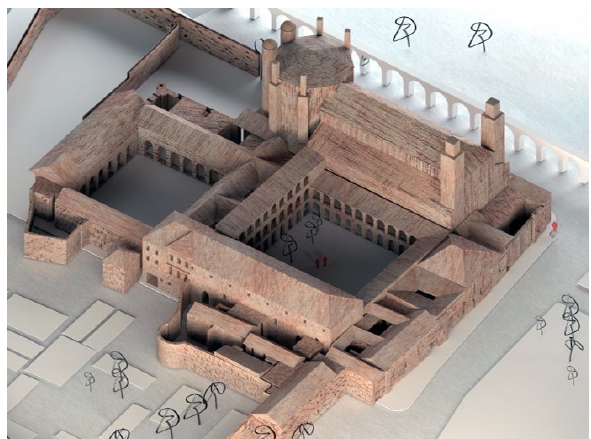
Figure 9. Hypothetical volumetry of the convent based